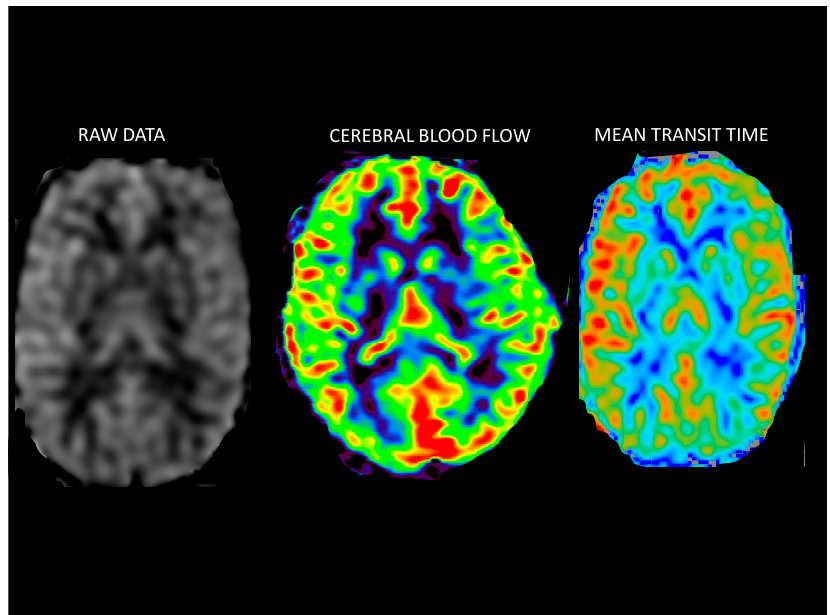
Figure 3. ASL perfusion sequence processing.